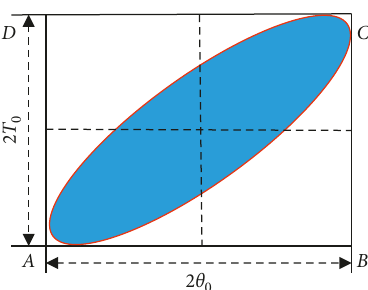
Figure 11: Hysteresis loop